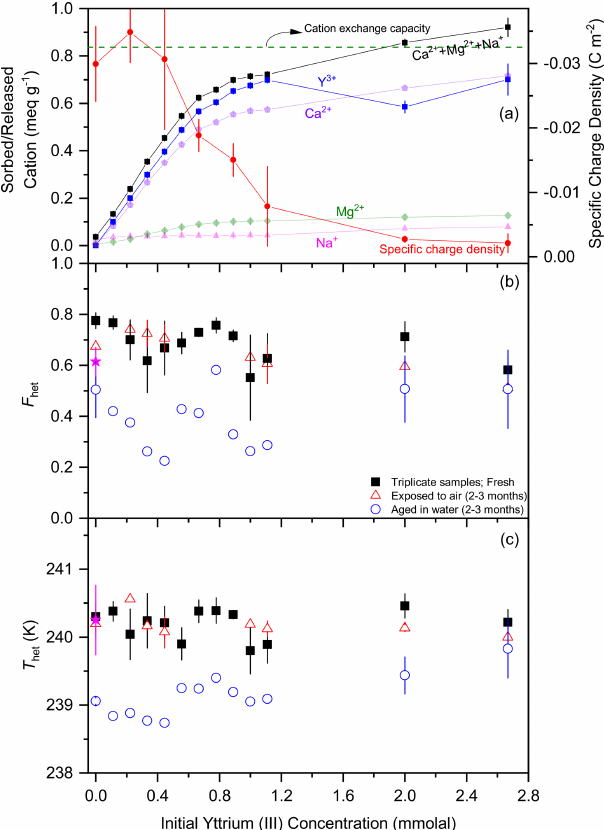
Figure 3. Ion exchange experiments as a function of Y 3 + con- centration in a 0.5wt% STx-1b suspension showing the effect of the stepwise exchange of the charge-balancing cations (Ca 2 + and minor amount of Mg 2 + , and Na + ) with Y 3 + on the IN activ- ity of the montmorillonite. Panel (a) shows sorbed Y 3 + together with released Ca 2 + , Mg 2 + and Na + as separate curves and sum to Ca 2 + + Mg 2 + + Na + (in terms of meqg − 1 ) (left scale) together with the specific charge density on the montmorillonite particle surface (right scale). The horizontal dashed green line marks the CEC as reported by CMS. DSC thermograms of the freshly ion- exchanged and lyophilized samples as 1wt% suspensions in pure water have been measured in triplicate (filled black squares with er- ror bars representing ± 1 SD) a few days after preparation and have been evaluated in terms of F het (b) and T het (c) . A few samples have been re-measured after 2–3 months either after storage in air (open red triangles) or aged in water (open blue circles). The black square at 0mmolalY 3 + marks the sample that was treated the same way as the ion-exchanged samples (including lyophilization). As a reference, filled magenta stars indicate F het and T het of the original STx-1b in